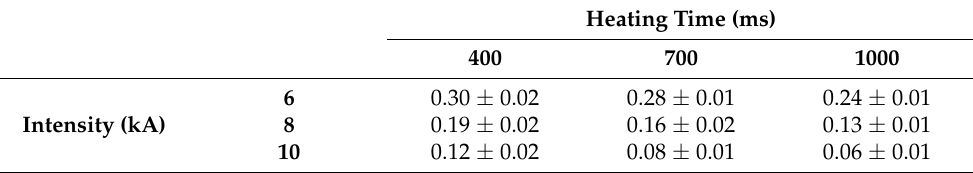
Table 1. Values of the compacts final porosity ( Θ F ) for the different MF-ERS experiments. The mean values and standard deviations were computed from the values measured in four compacts obtained under identical conditions.